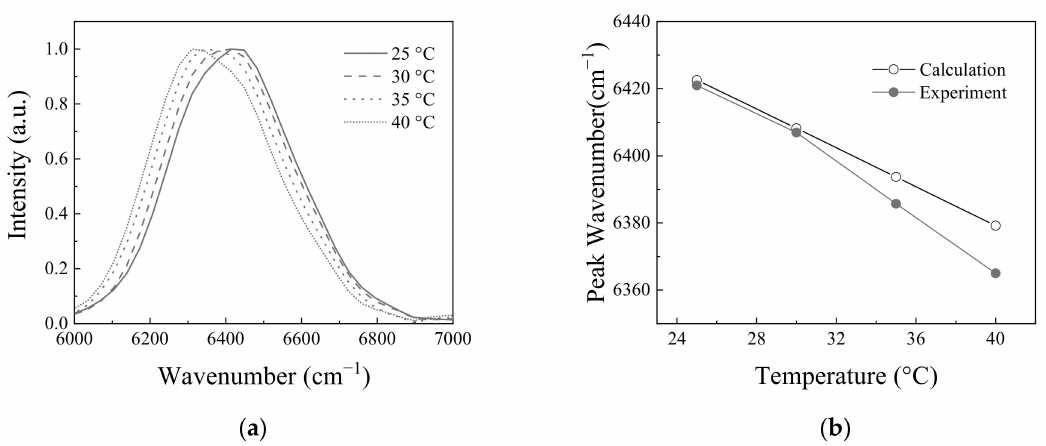
Figure 5. ( a ) Spectrum change according to the temperature: ( b ) The change of peak wavenumber according to temperature. Calculation values are calculated by Equations (5) and (6). Experimental values are from the measured values by static modulated Fourier transform spectrometer. Applied current to light emitting diode was fixed to 0.55 A.